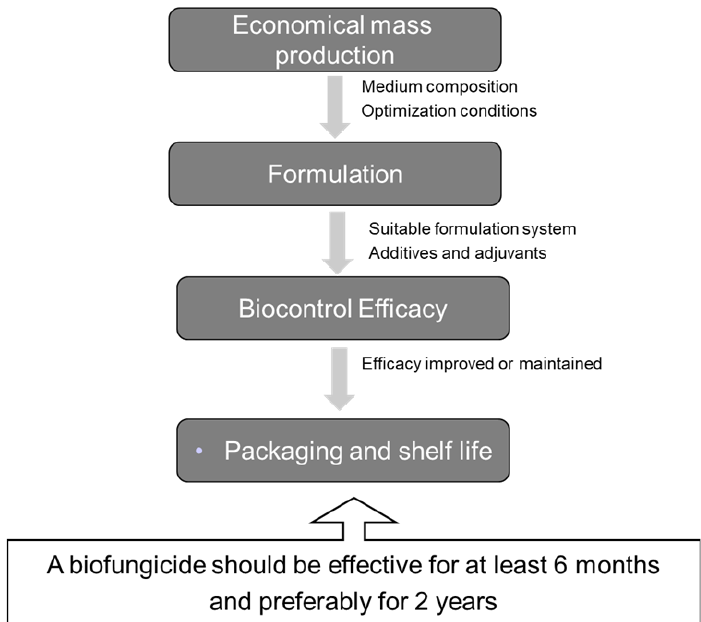
Figure 1. Different steps required in the development process of BCAs.